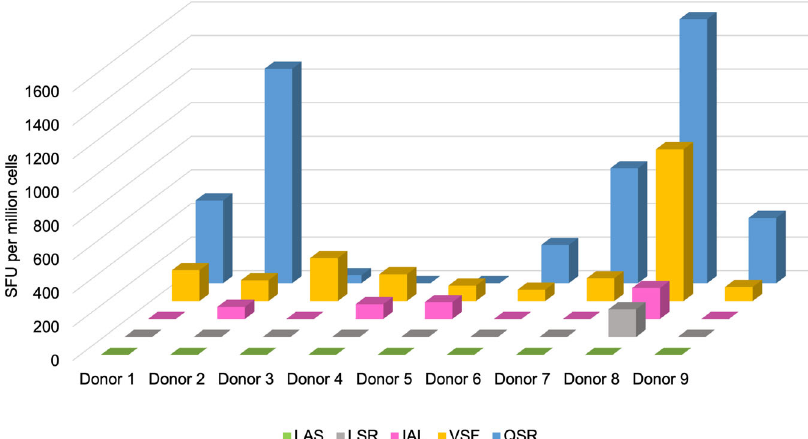
Fig. 7 Frequency of T cell responses to HLA-B*57:01 restricted EBV epitopes. The peptides speci fi c to EBNA2 (LASAMRML; LAS), EBNA1 (LSRLPFGMA; LSR), LMP1 (IALYLQQNW; IAL), EBNA3B (VSFIEFVGW; VSF), and EBNA3C (QSRGDENRGW; QSR), were tested by IFN γ ELISpot across six EBV + HLA- B*57:01 + donors (Donor 1 – 6) plus three additional donors (Donor 7 – 9). T cell responses were tested by pulsing K562-B*57:01 with individual peptides followed by incubation with donor PBMCs. Data are mean spot forming units (SFU) from triplicate